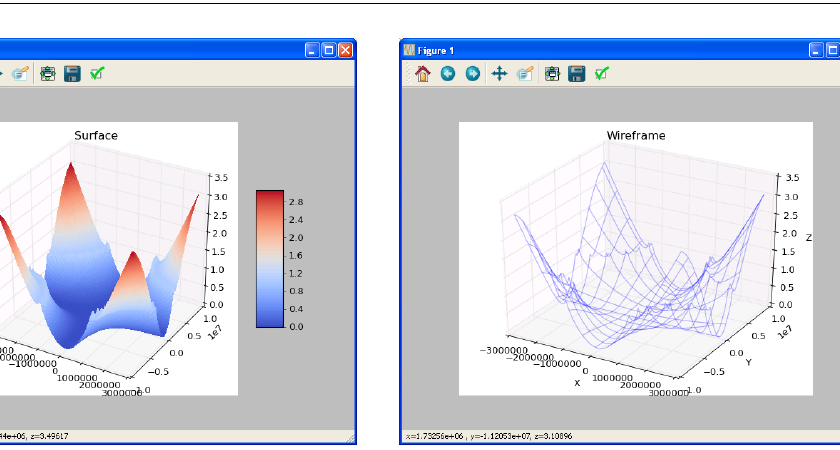
x = fig.add_subplot (111 projection = ‘3D’) x.plot_surface (X, Y, Z)